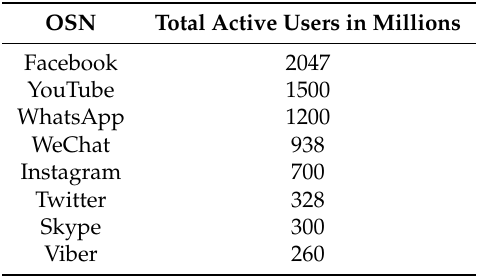
Table 1. Popular Online Social Networks (OSNs) and their total active users in millions.